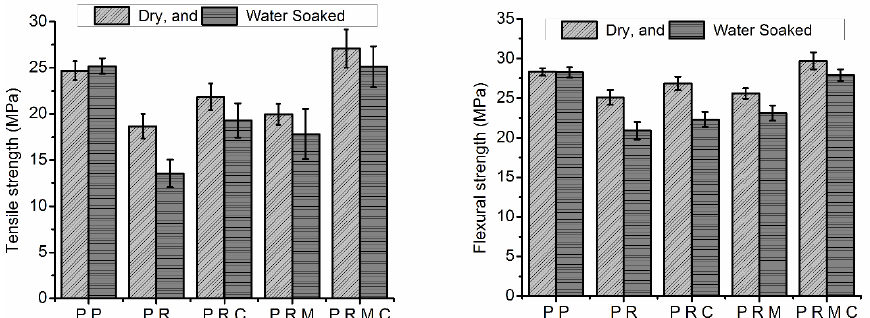
Figure 5. Tensile and flexural modulus of neat PP and its composites under dry and wet conditions.